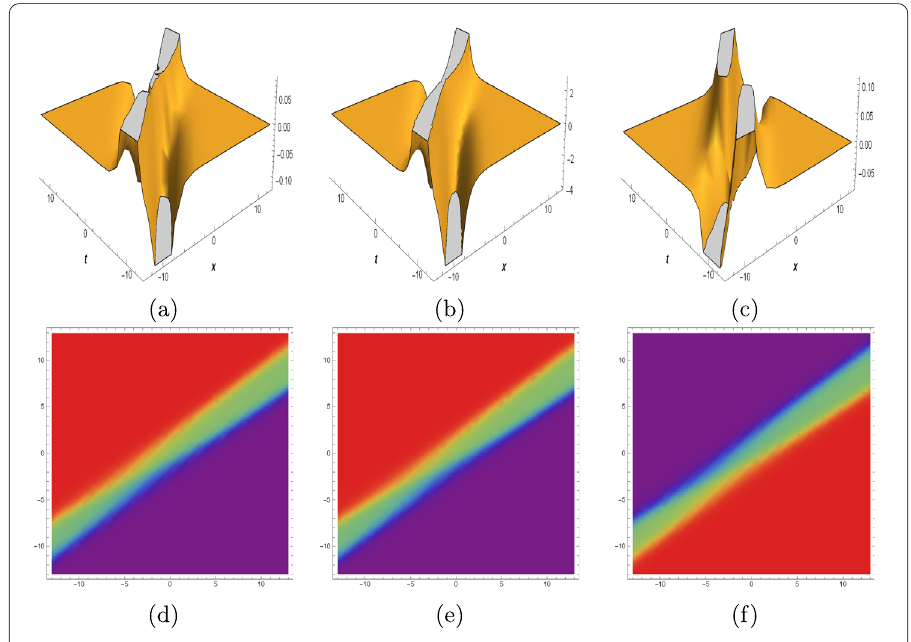
Figure 3 The 3D and density profiles of imaginary part of Eq. (11) for b 2 = 1.23, b 3 = 2.04, b 7 = 2.19, T 1 = 1, T = 1